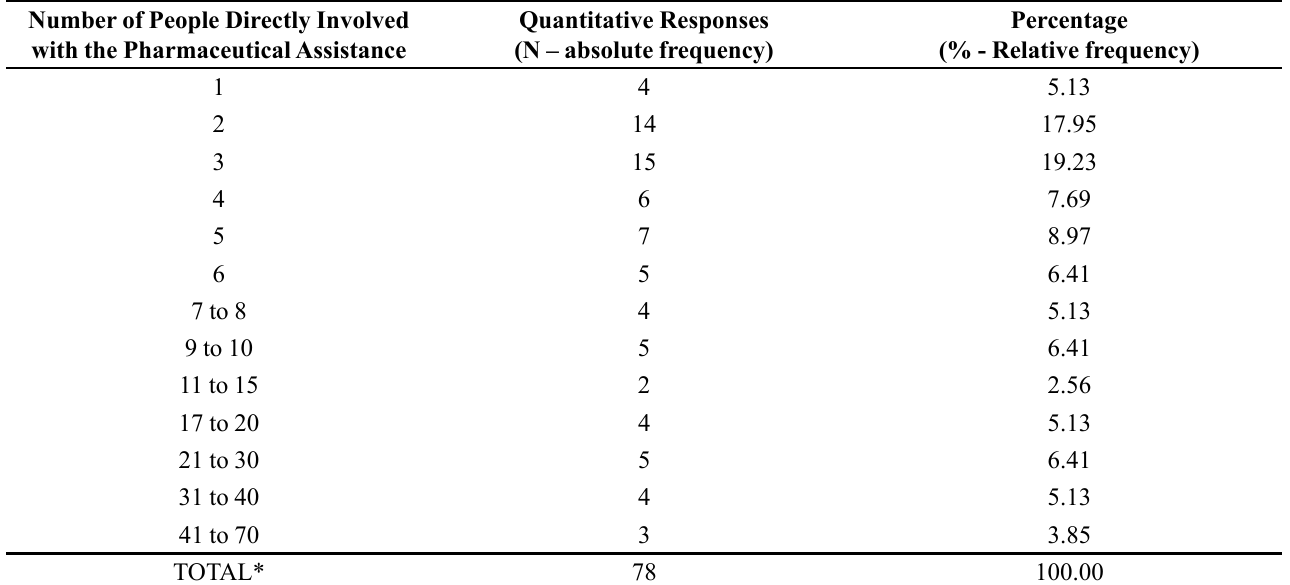
TABLE II - Distribution Frequency of professionals directly involved with the pharmaceutical assistance in relation to workplace in Maranhão’s municipalities (N = 78) Number of People Directly Involved with the Pharmaceutical